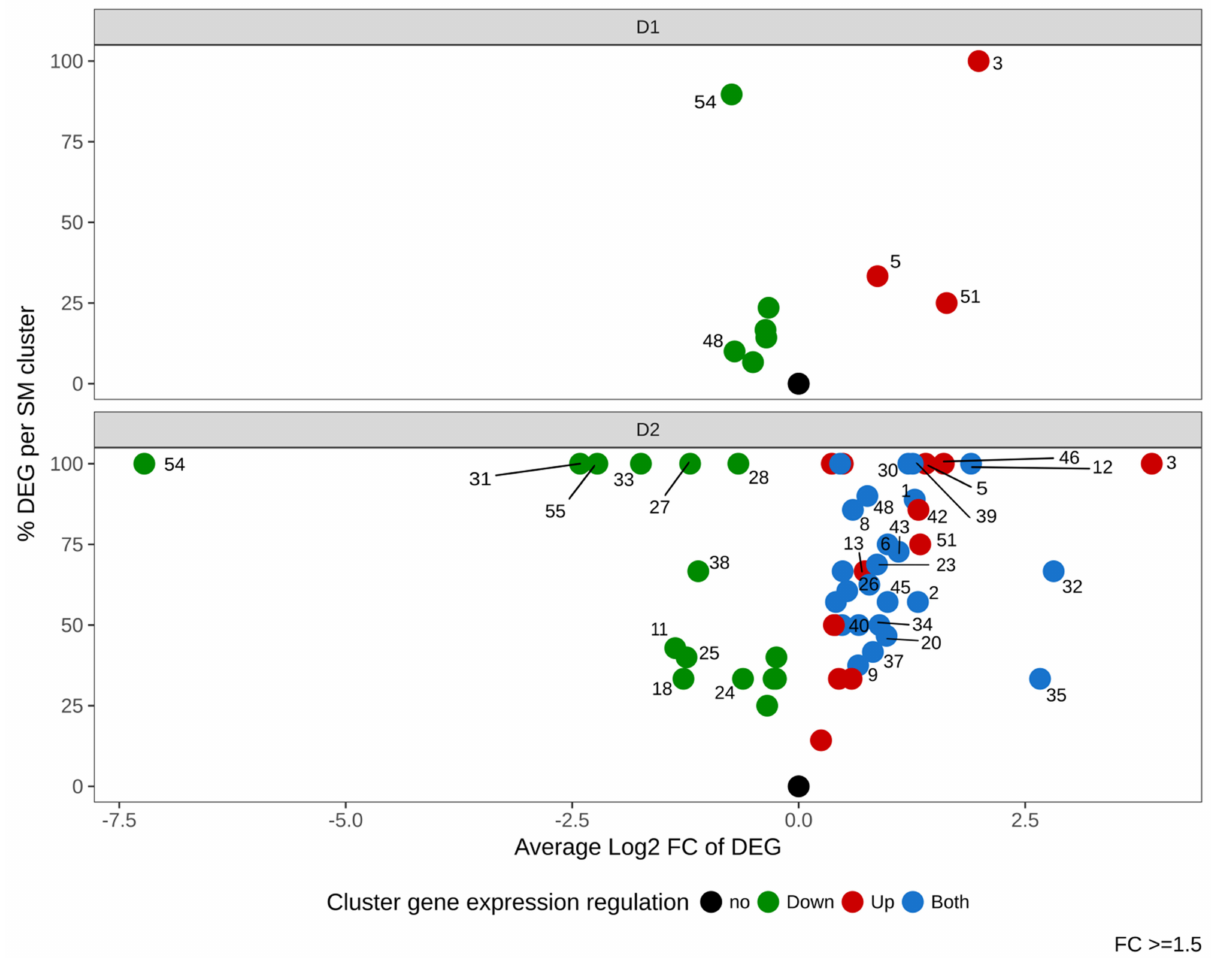
Figure 7. Summarized gene expression regulation of the 56 Secondary Metabolites Gene Clusters (SMC) of Aspergillus flavus in response to DMSO (D1 and D2). The x-axis represents the average gene expression log 2 Fold Change in each SMC (“intensity of the regulation”). The y-axis shows the percentage of differentially expressed genes (DEG) within all genes of the SMC (nb DEG/nb detected genes). Green, red and blue dots indicate down-regulated, up-regulated and mixed-regulated (both up and down-regulated) clusters, respectively. The numbers of clusters with FC ≥ 1.5 (log 2 FC ≥ 0.58) are labeled next to the colored